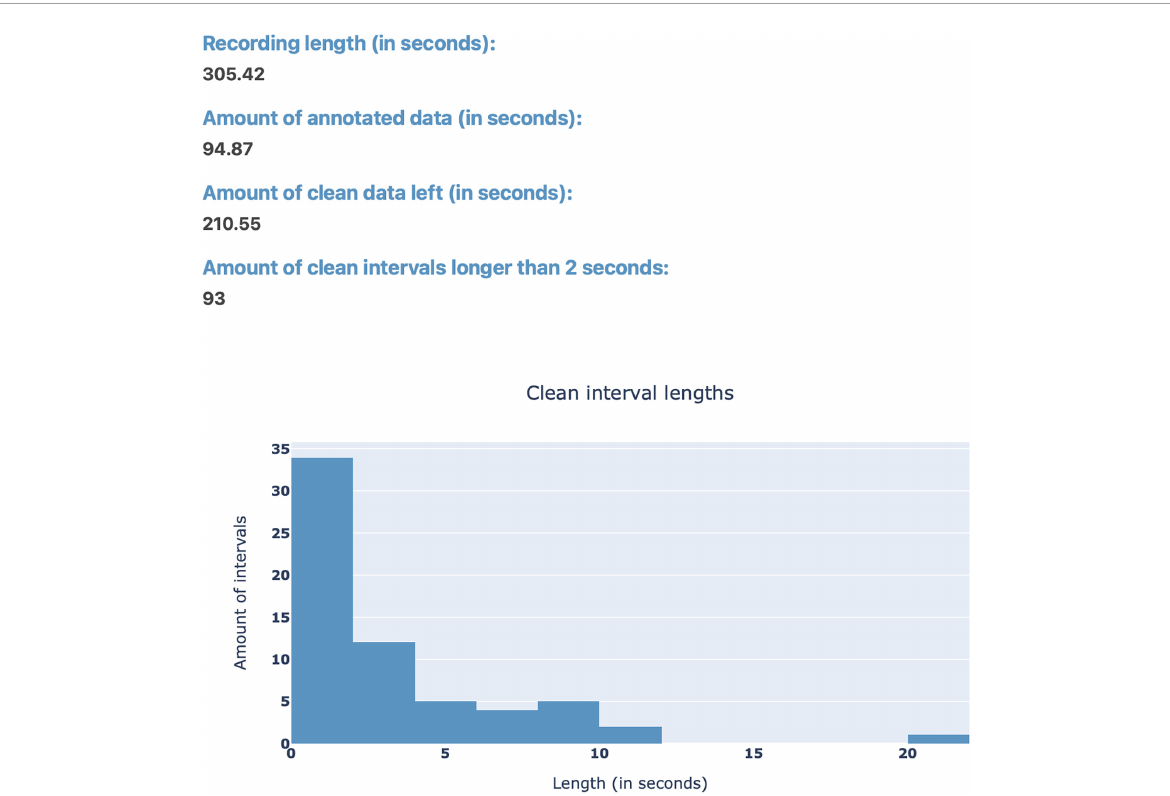
custom reference). This is to avoid the situation where,